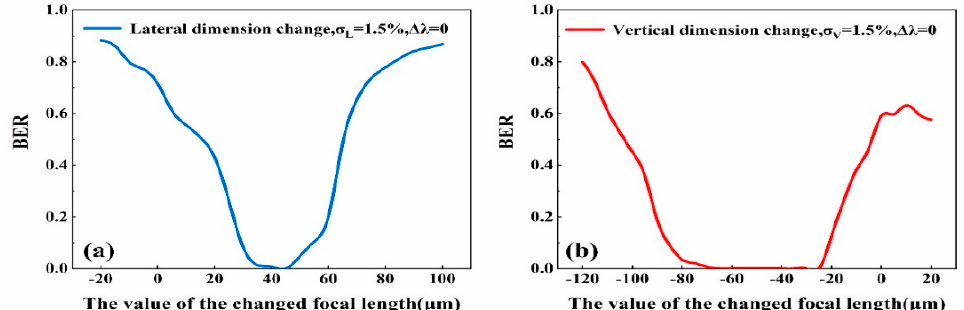
Figure 6. The BER with different objective focal length adjustments for ( a ) the lateral dimension change condition ( σ L = 1.5%) and ( b ) the vertical dimension change condition ( σ V = 1.5%) when the wavelength of the reading light was unchanged.